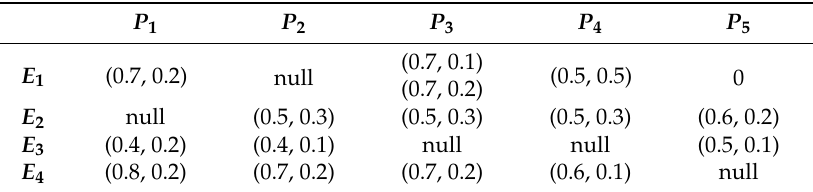
Table 3. The raw reputation rating matrix M 2 .